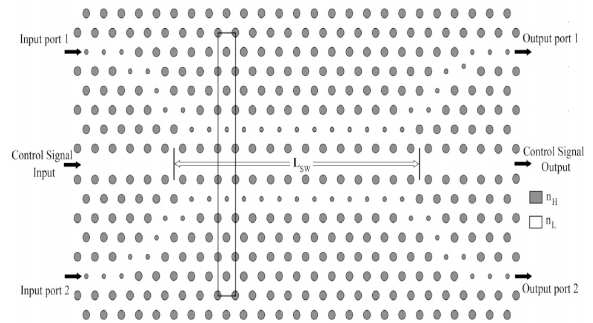
Figure 2: Structure of the proposed all-optical switch based on a PhC directional coupler.